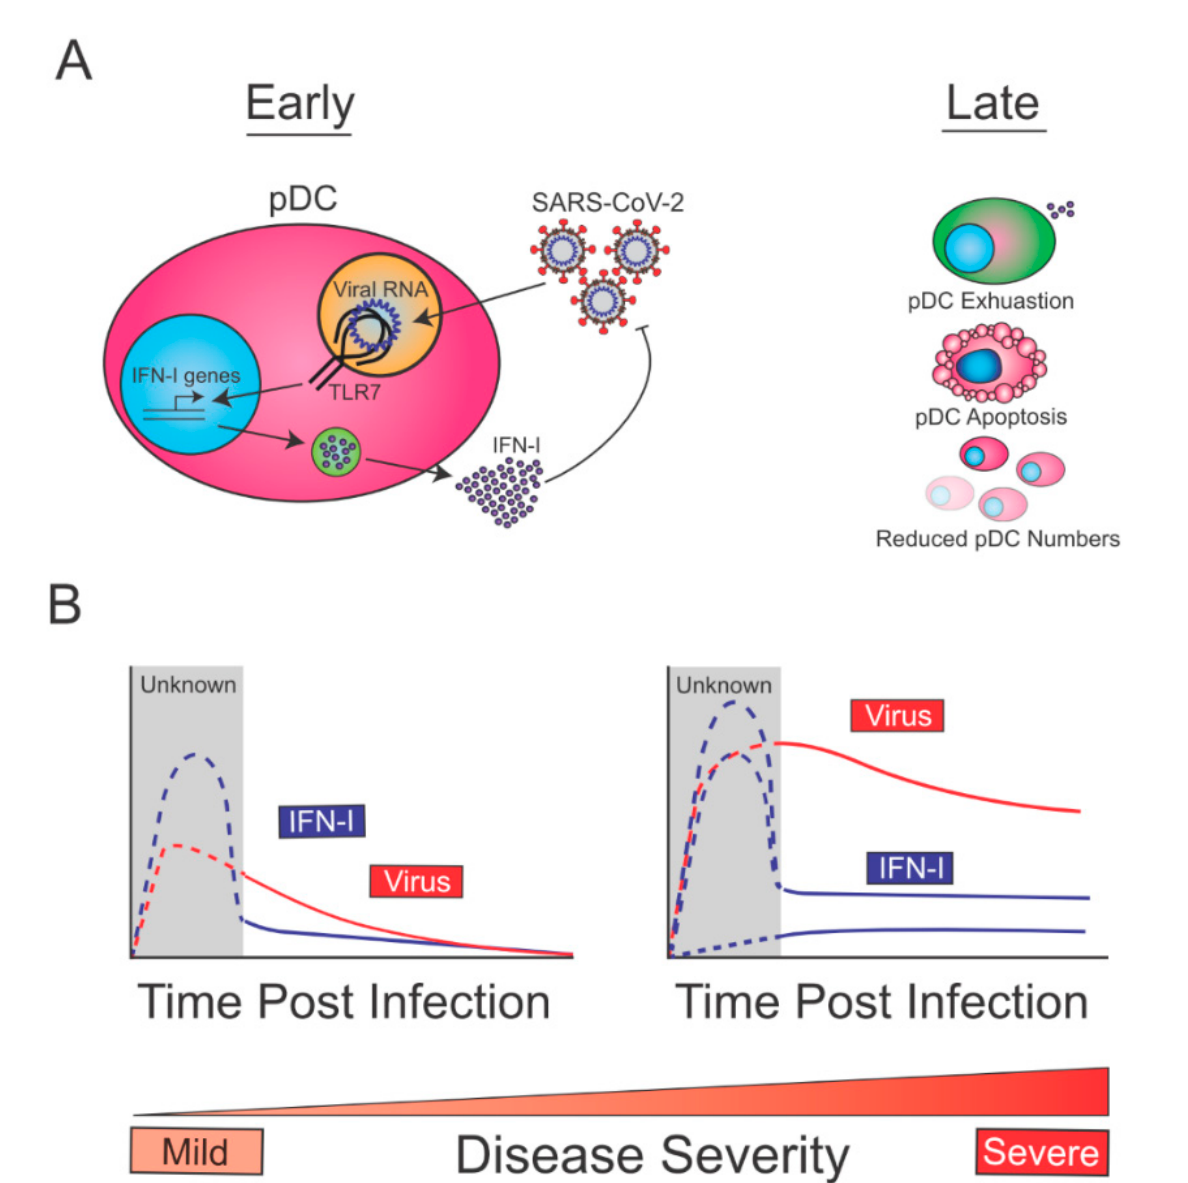
Figure 1. Biology of pDCs during SARS-CoV-2 Infection. ( A , left) pDC are likely to uptake viral material independent of cell-intrinsic infection, and to sense SARS-CoV-2 RNA via TLR7. This first step stimulates the production of IFN-I which promotes early viral control. ( A , right) Late after infection blood pDCs become hypofunctional (exhausted), undergo apoptosis and show reduced numbers, and all this may limit pDC derived IFN-I. ( B , left) pDC from patients with mild disease are expected to produce high IFN-I levels promoting the control of SARS-CoV-2 early after infection. ( B , right) On the other hand, individuals with severe disease course may exhibit varying degrees of pDC-IFN-I production. The latter may range from low pDC-derived IFN-I in patients with defective TLR7 signaling to normal or even enhanced pDC-derived IFN-I in patients with defects in other immune pathways, or infected with a high viral inoculum or a fast-replicating variant. In such individuals the initial IFN-I wave is expected to be present but insufficient to contain the virus, which may result in sustained stimulation of IFN-I production by a variety of cell types. Importantly, the viral loads or IFN-I levels have not been measured in patients at early times post infection, prior to symptom development, and so the levels of this initial IFN-I response are hypothetical (dotted